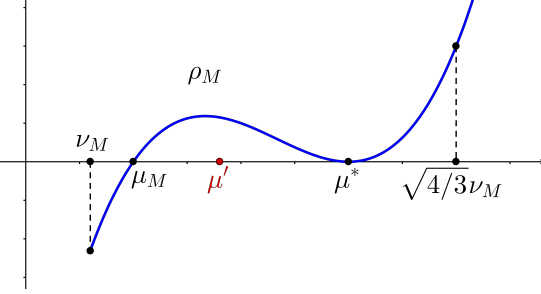
Figure 5. Plot of the map ρ : [ ν M , ∞ ) → R